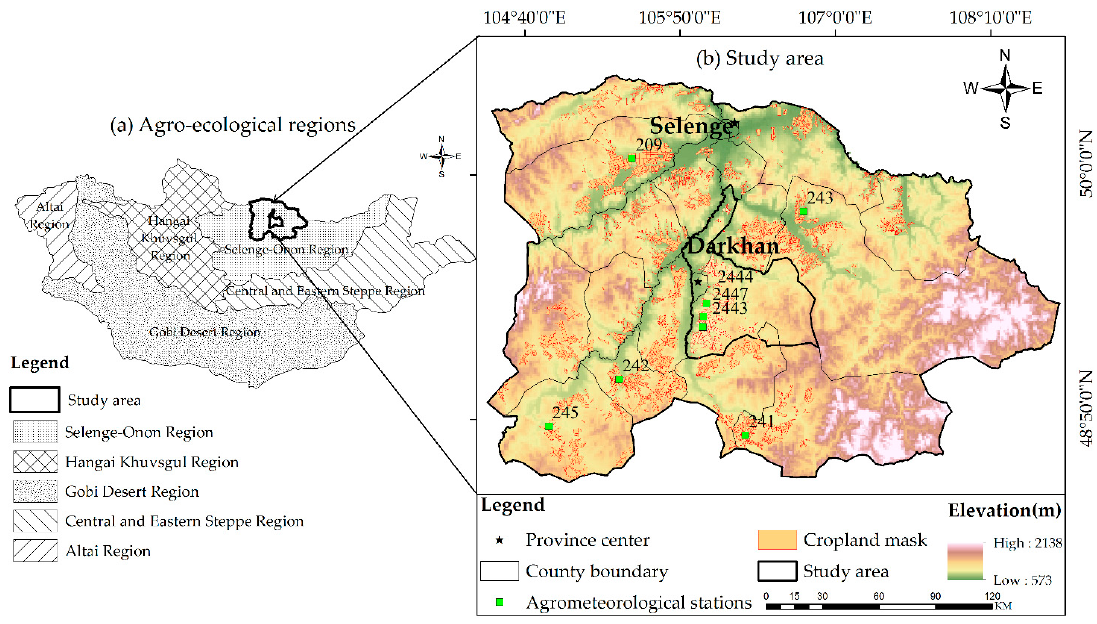
Figure 2. Study area: ( a ) Agro-ecological regions of Mongolia; ( b ) Digital Elevation Model data (DEM), Spatial distribution of agrometeorological stations in Selenge and Darkhan provinces and cropland.